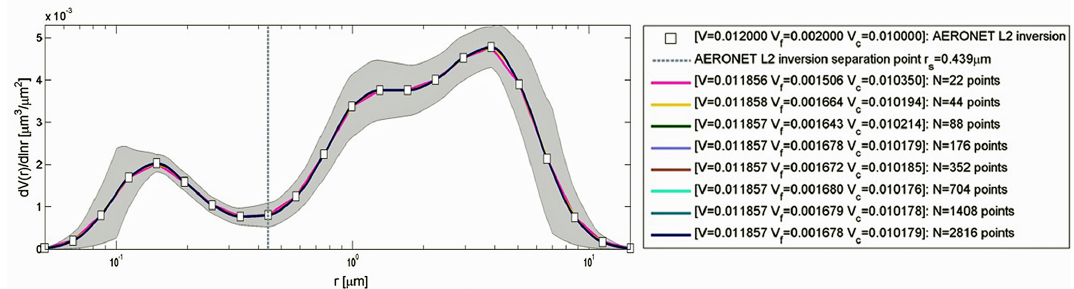
Fig. 1. Interpolation of the AVSD with between 22 and 2816 equidistant logarithmically spaced points (7 doublings) for dominant marine (sea salt) aerosol at Lanai on 21 January 2002. Only the interpolations with 22 points (pink) and 44 points (yellow) show visible deviations from the interpolation having the maximum 2816 points. Also shown is the value of the mode separation point r s = 0.439µm provided by the AERONET retrieval on this day. The grey band is the uncertainty on the AERONET AVSD obtained by following the approach described in the